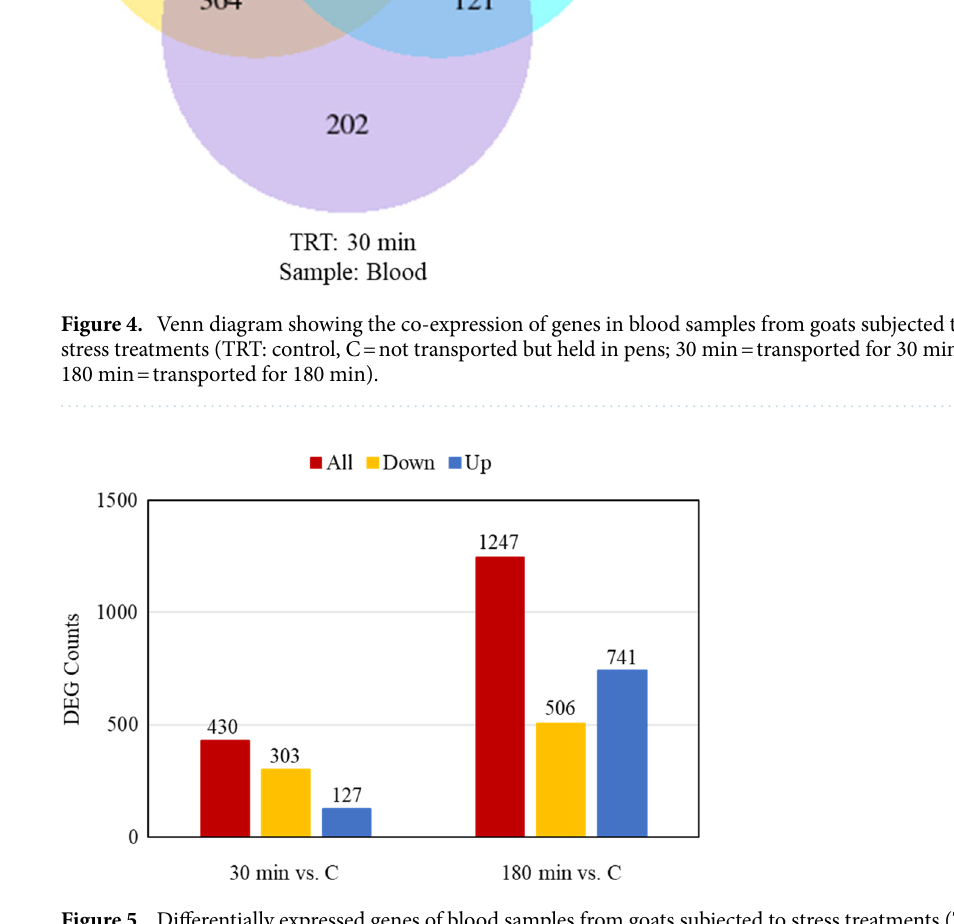
Figure 5. Differentially expressed genes of blood samples from goats subjected to stress treatments (TRT: control, C = not transported but held in pens; 30 min = transported for 30 min; or 180 min = transported for 180